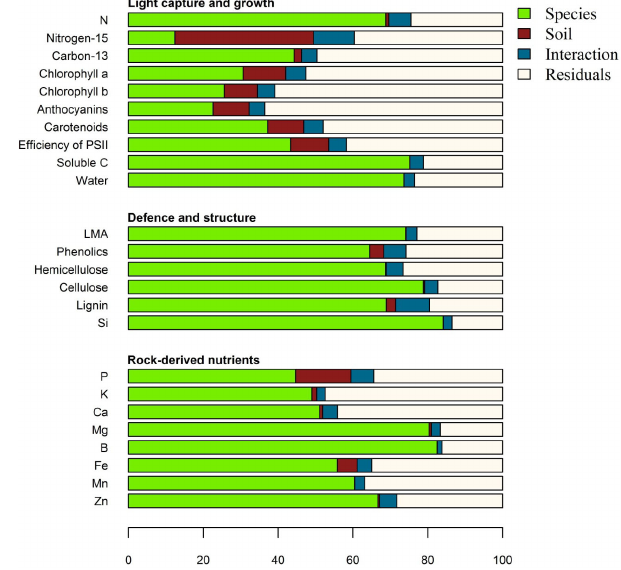
Figure 4. Spearman correlation rank test among leaf traits of six species growing on both soil types. Red and black circles mean, respectively, negative and positive correlations. Foliar traits were organised using cluster analysis.